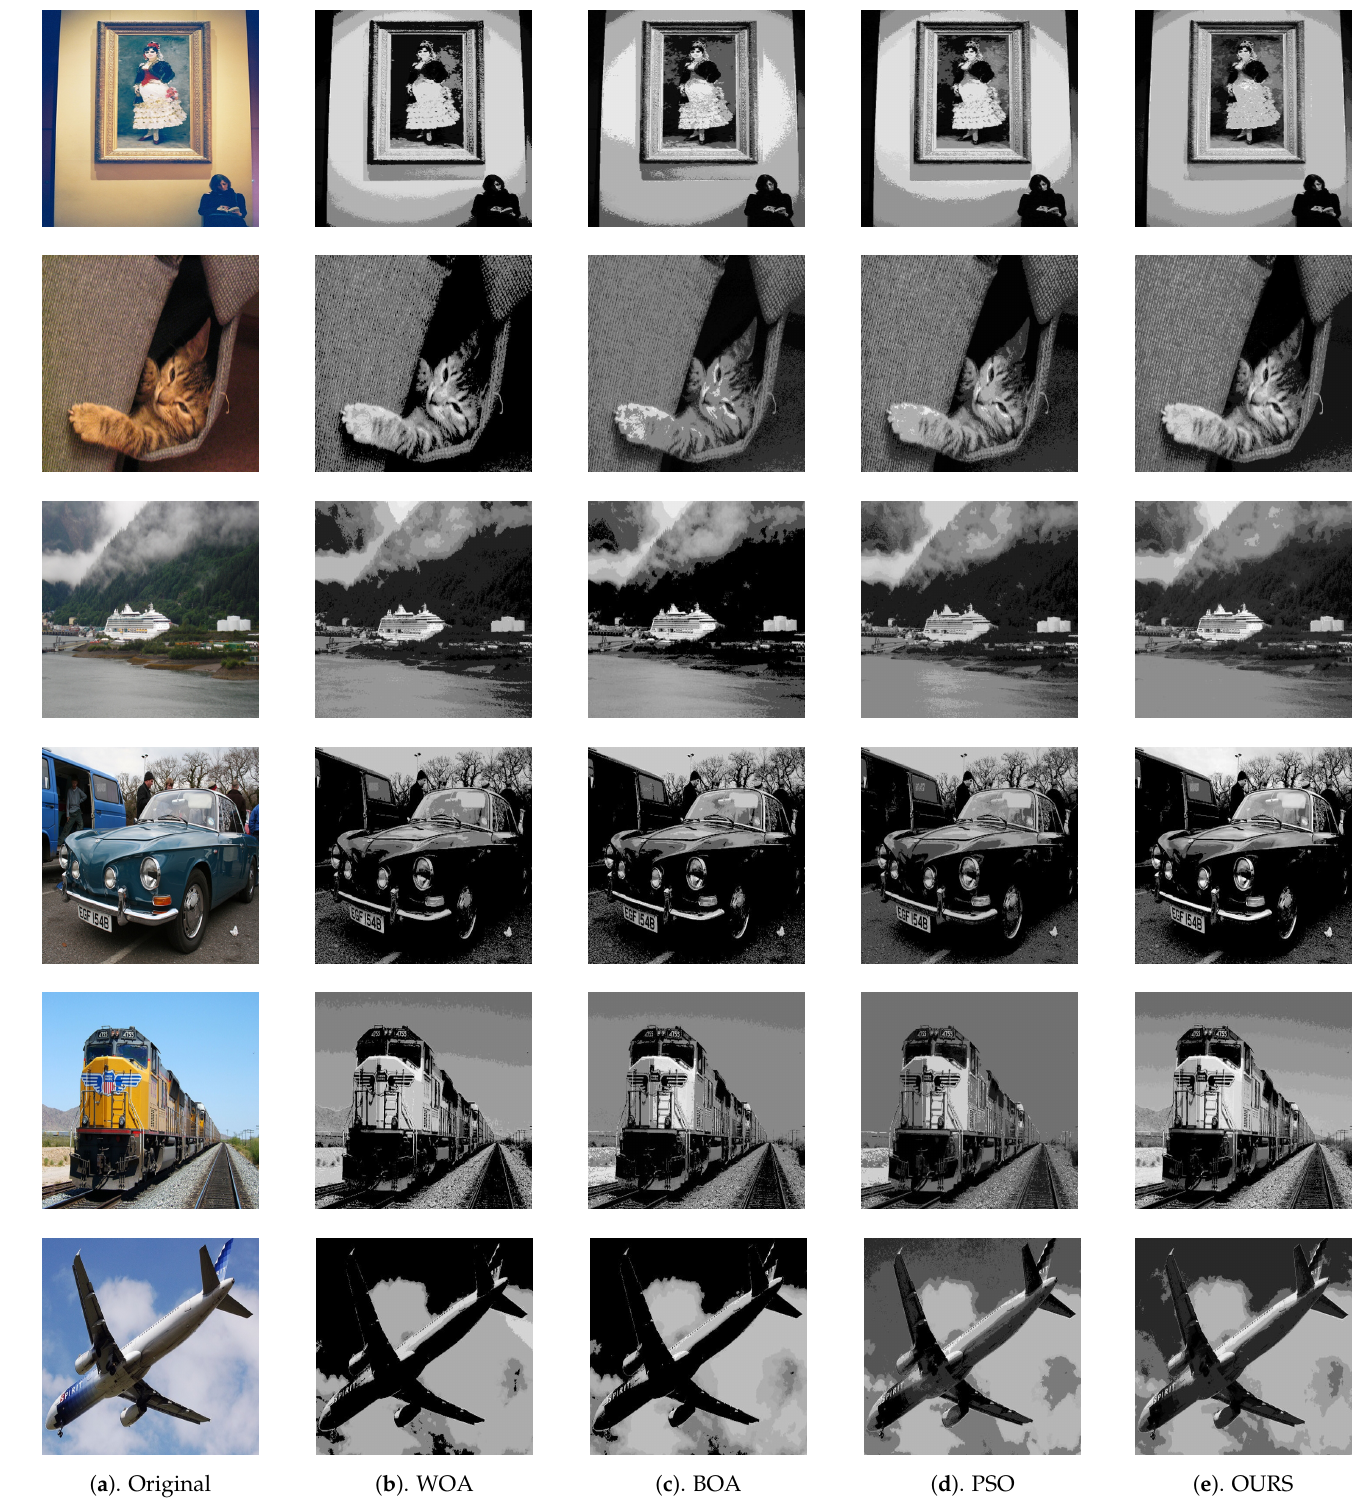
Figure 7. When threshold k = 8, the original image and the segmented image of different algorithms are shown (images g–l in Figure